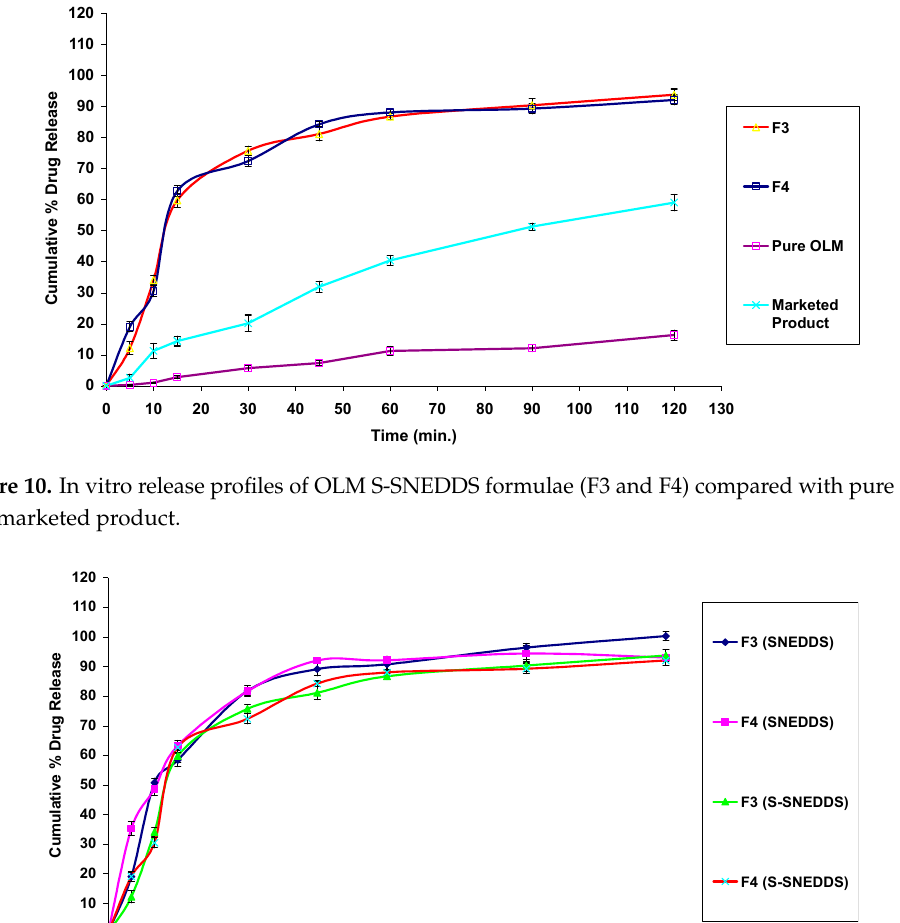
S-SNEDDS (F3) Market Product Pure Drug Figure 12. Plasma concentration-time profiles of OLM after oral administration of optimized S-SNEDDS formula (F3), Marketed product and pure drug in rats ( n = 6). As depicted in Table 11, the maximum concentration ( C max ) of OLM S-SNEDDS formula (F3) was 26.4320 ± 1.89 µg/mL, compared with marketed product which was 15.3365 ± 2.18 µg/mL and pure drug which was 9.5562 ± 2.37 µg/mL. The C max was enhanced 1.72 and 2.77 fold as compared with marketed product and pure drug respectively. It was also observed that OLM S-SNEDDS formula (F3) showed high area under the curve value (299.7304 ± 4.15 µg·h/mL) in comparison with marketed product (208.3887 ± 6.47 µg·h/mL) and pure drug (143.2684 ± 3.59 µg·h/mL) indicating rapid absorption and higher bioavailability of OLM from S-SNEDDS formula (F3). The relative bioavailability of OLM in S-SNEDDS formula was about 1.44 fold compared with marketed product and about 2.09 fold compared to pure drug.